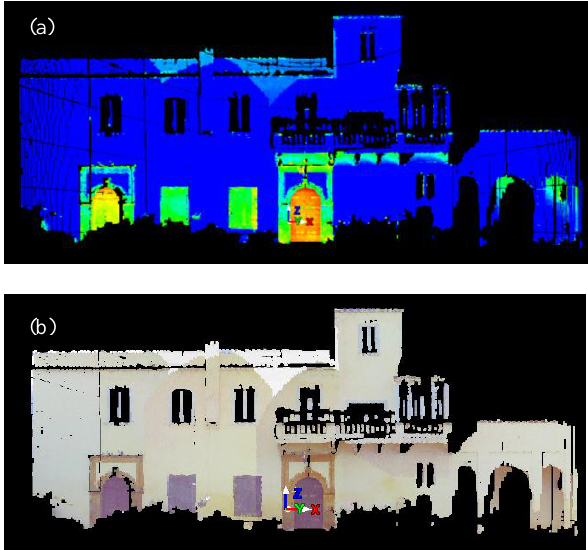
Figure 2. The appearance of point cloud according to: (a) the laser intensity level, (b) the RGB color